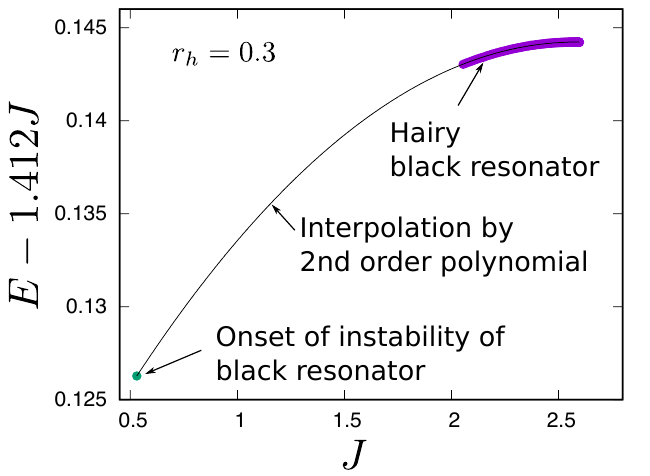
Figure 8 . Energy of the hairy black resonator as a function of the angular momentum J for a fixed horizon radius r = 0 . 3 h